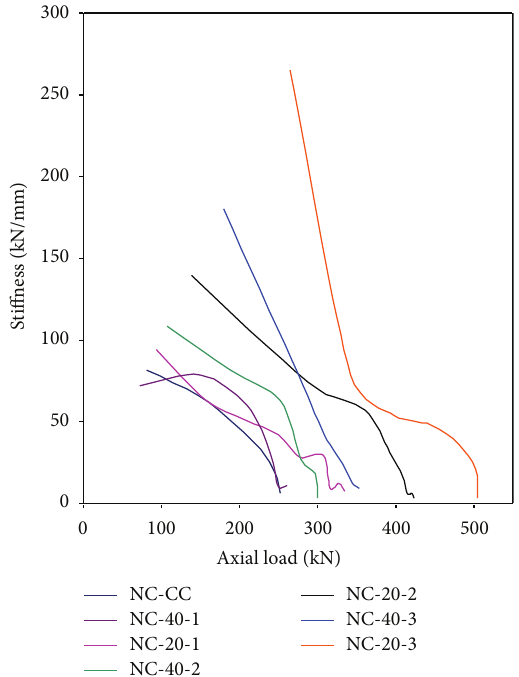
Figure 20: Stiffness value of all strengthened columns, comparison.